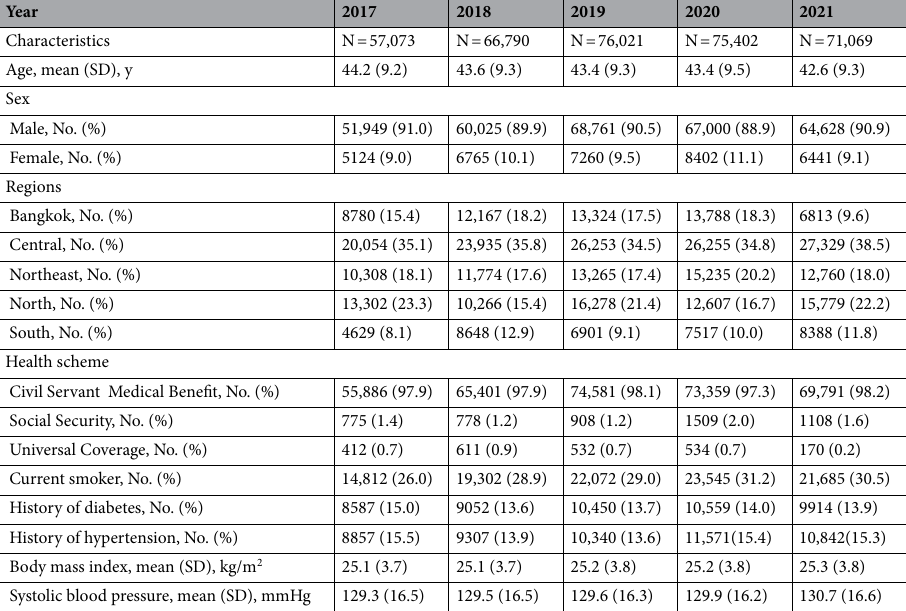
Table 1. Characteristics of participants from 2017 to 2021 (N = 346,355). SD; standard